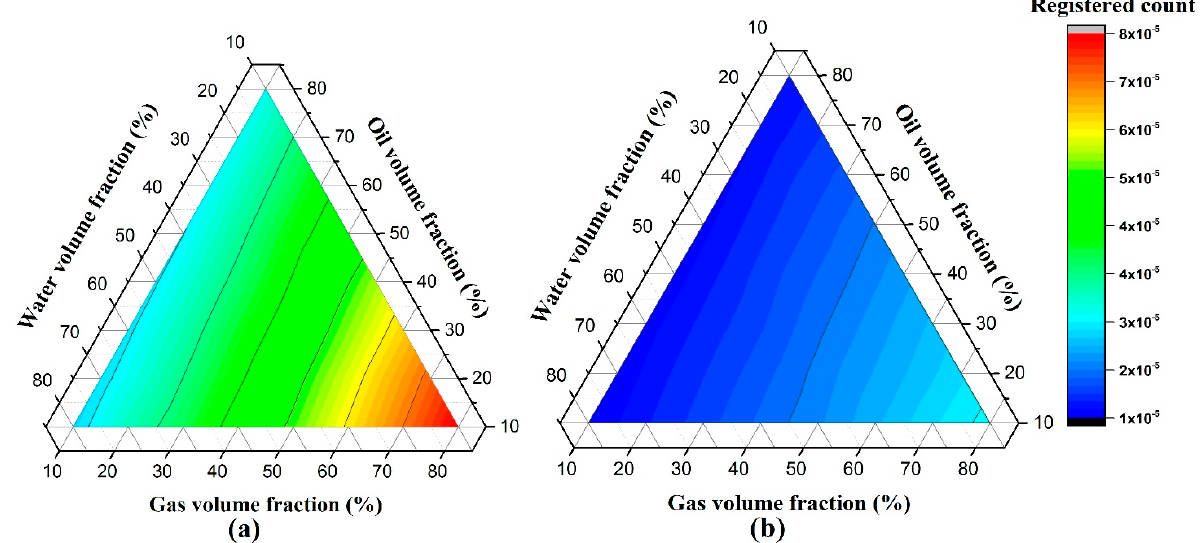
Figure 8. Recorded counts under photo peaks of 133 Ba in the first detector versus gas, oil, and water volume fraction: ( a ) scale thickness is 0, ( b ) scale thickness is 3 cm.